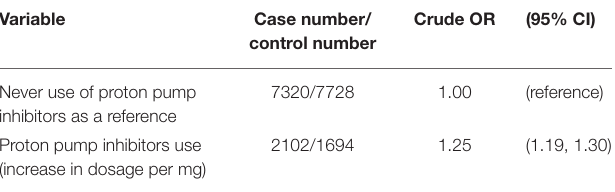
TABLE 3 | Odds ratio and 95% confidence interval of pulmonary tuberculosis in relation to cumulative dosage of proton pump inhibitors use by logistical regression